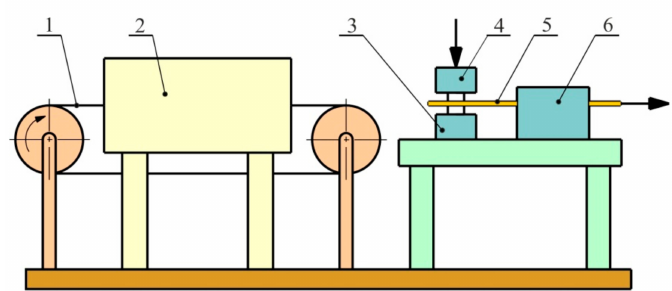
Figure 6. Schematic representation of a hot strip drawing simulator: 1—chain, 2—electric furnace, 3—tool holder, 4—movable tool holder, 5—heated sheet metal strip, 6—sliding bed with a hydraulic holding down device; prepared on the basis of